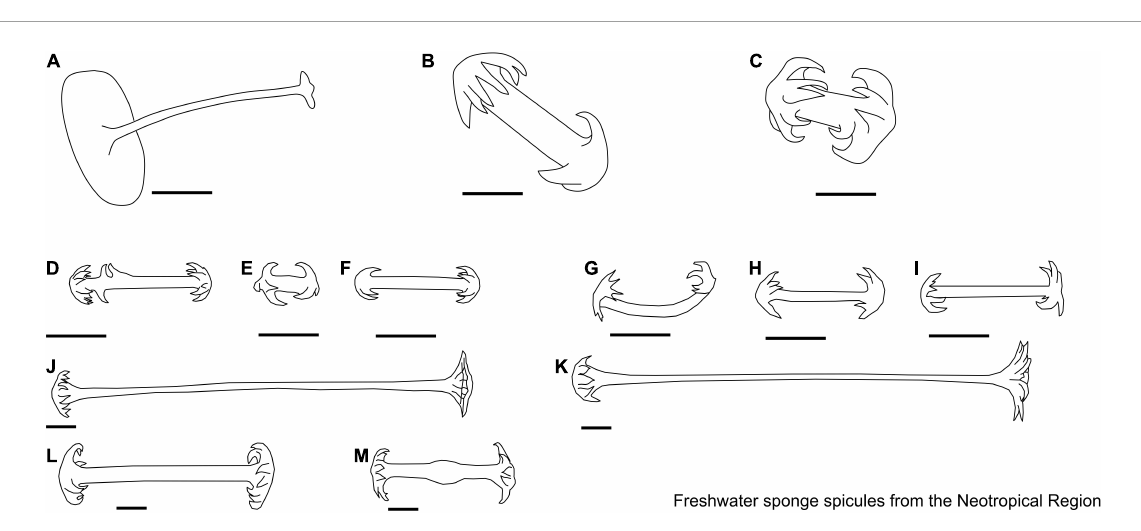
FIGURE10 (A–C) Acalle Gray, 1867. Gemmuloscleres. (A) Tubelliform; (B,C) pseudobirotule. (D–M) Corvomeyenia Weltner, 1913. Microscleres. (D–F) Microbirotules with regularly cropped rotules; (G–I) pseudobirotules. Gemmuloscleres. (J,K) Pseudobirotules with long, smooth, delicate shafts, and strongly unbonneted rotules; (L,M) pseudobirotules have small thicknesses, rotules formed, and bearing at their edge six small or quite large, incurved hooks. Scale: 10 µ